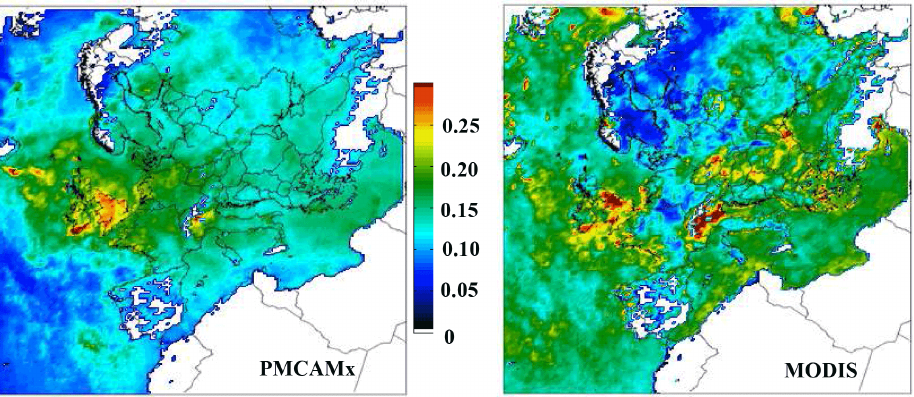
Figure 3. Monthly mean AODs from PMCAMx and MODIS (QAC ≥ 1) during May 2008. White color denotes no AOD retrieval. A coarse particle rejection filter has been employed. The PMCAMx AODs correspond to the periods of the MODIS